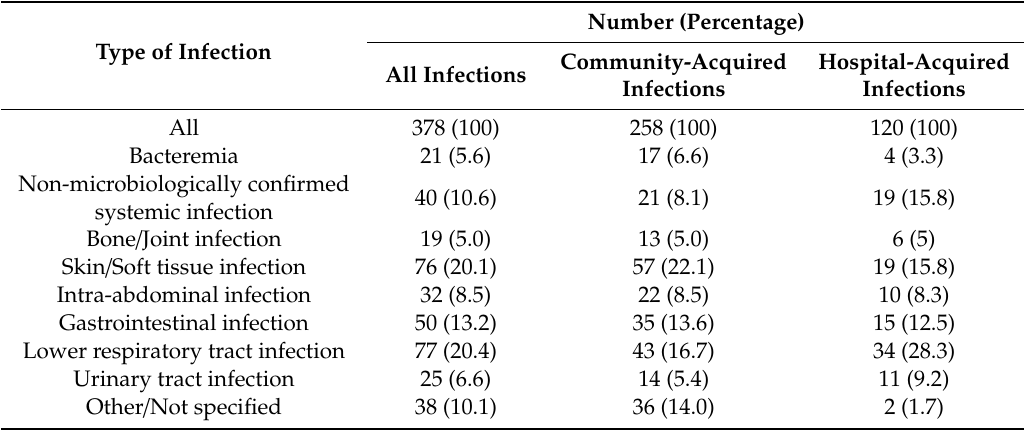
Table 3. Types of infections of redundant anaerobic antimicrobial treatments. Data from 218 hospitals that participated in the point prevalence survey 2016.